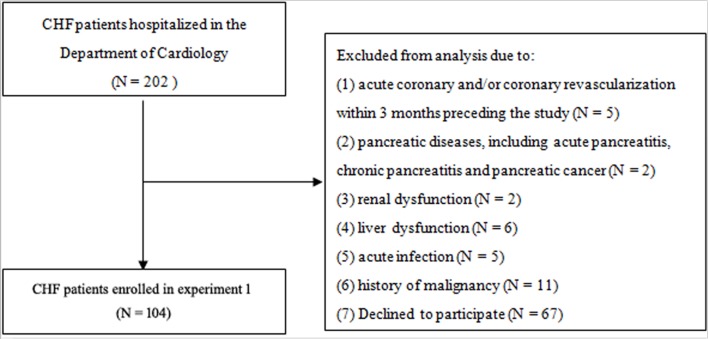
Flow diagram of patients selection in experiment 1.